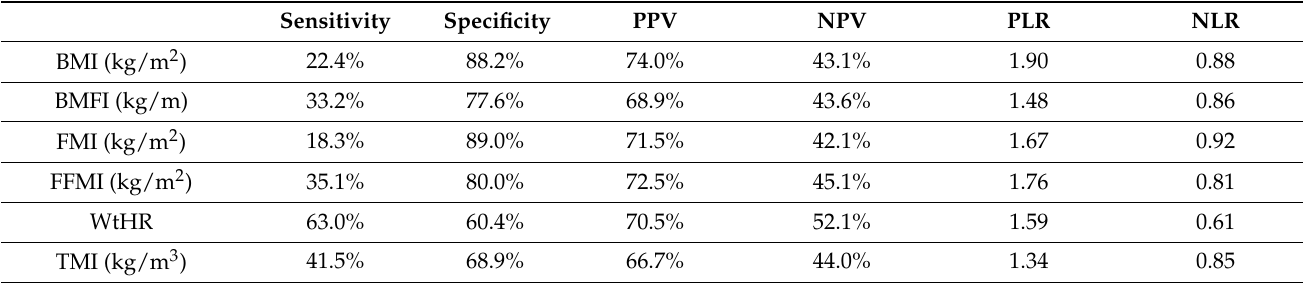
Table 3. Sensitivity, Specificity, Positive Predictive Value, Negative Predictive Value, Positive Likelihood Ratio, and Negative Likelihood Ratio for each anthropometric measure in identifying